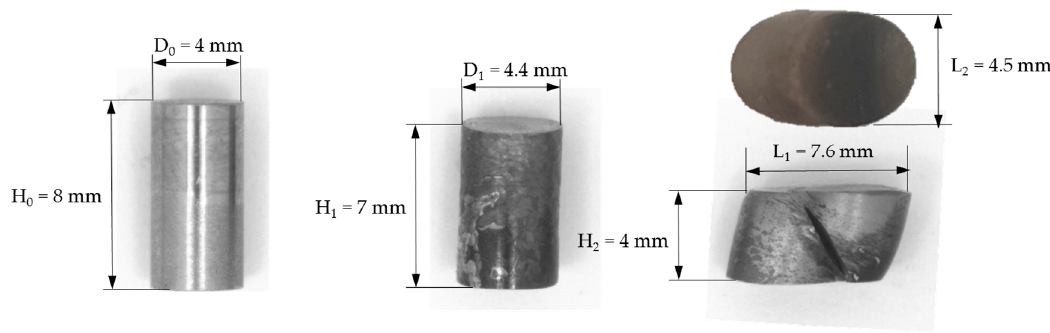
Figure 10. Initial specimen geometry ( left ) and compressed specimen geometry ( right ).